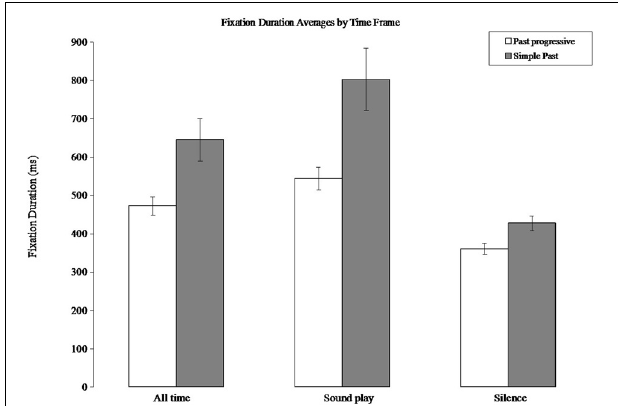
FIGURE 2 | Fixation duration averages in simple past and past progressive conditions by time frame. “All time” is pooled across the sound playing and silence data. The average fixation durations are shorter in the progressive condition where the grammar implies an emphasis on motion. Error bars are